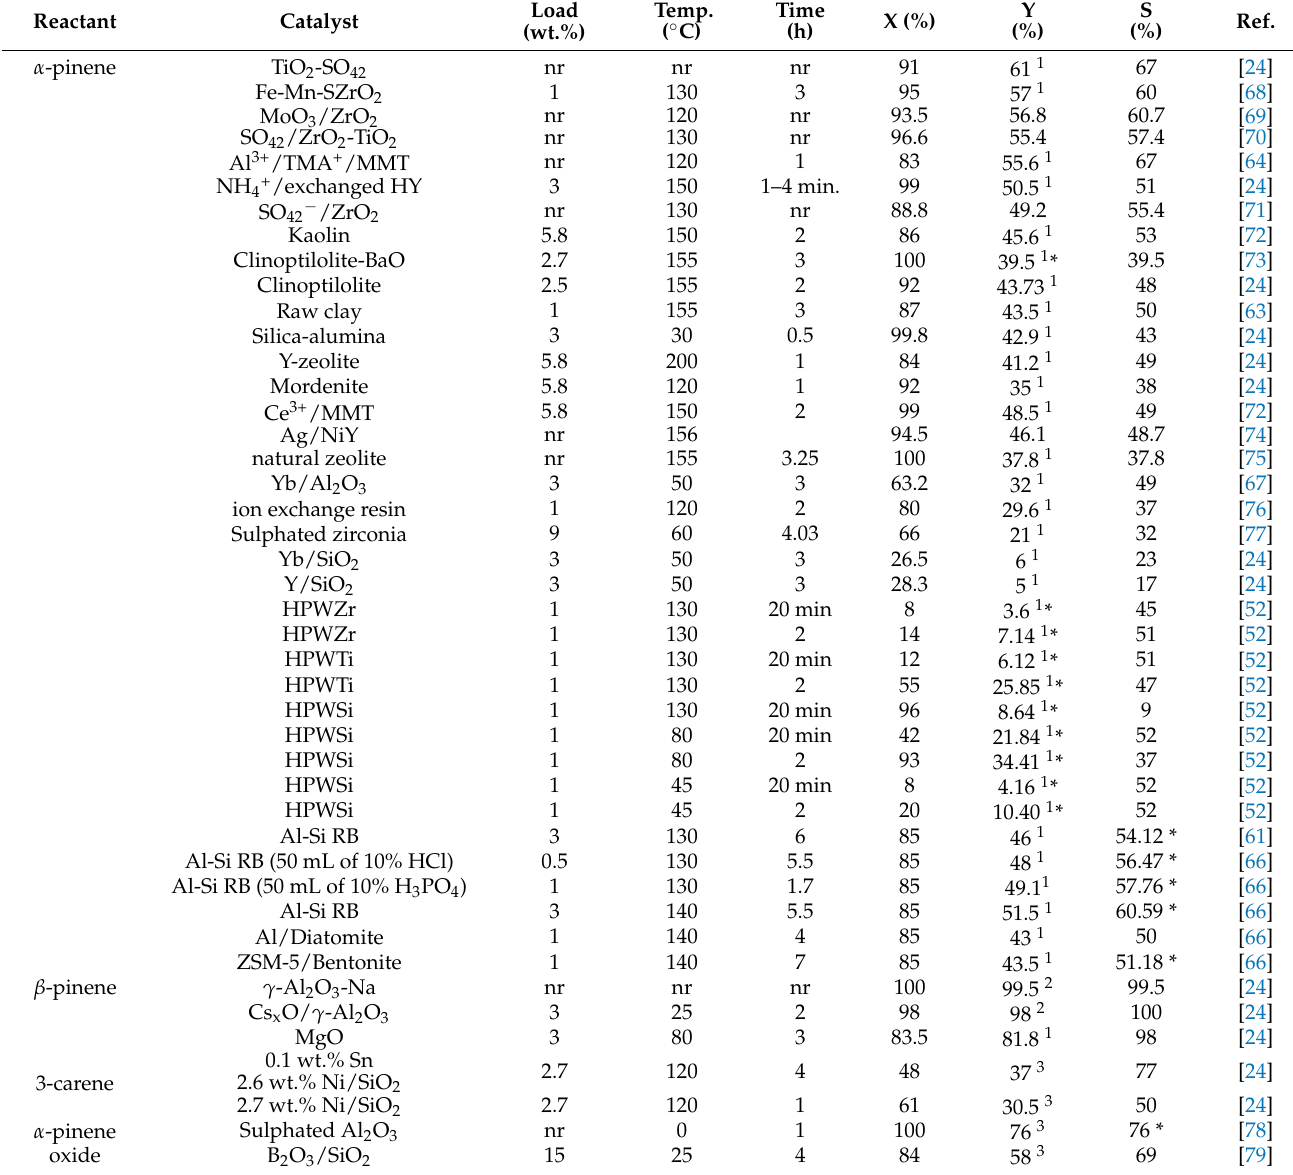
Table 3. Catalytic isomerization of terpenes (1